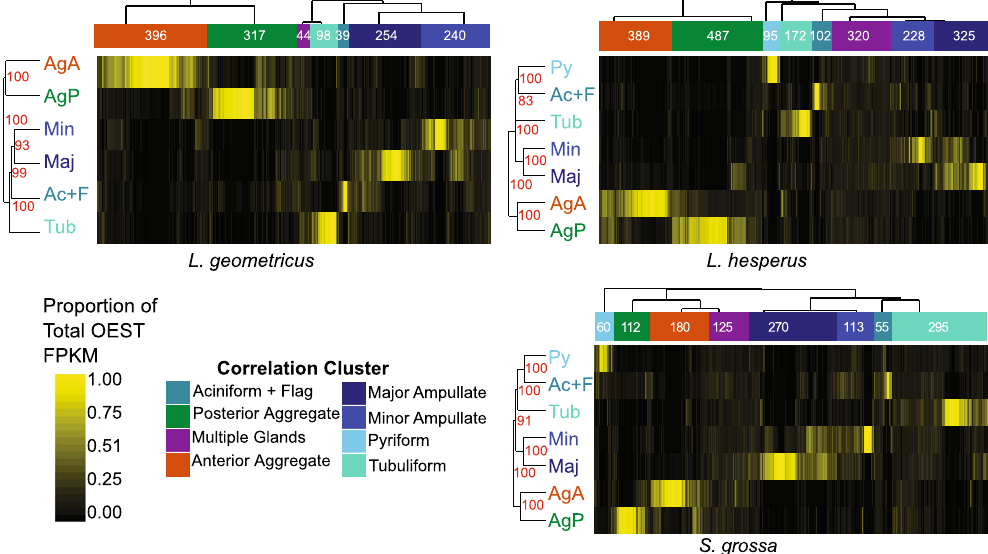
Figure 4. Expression patterns of over-expressed silk transcripts (OESTs). Within each focal species, transcripts significantly more abundant in silk glands than non-silk gland tissues (FDR < 0.05) were identified with edgeR. The common dispersions (CV 2 ) were 1.56 ( L . geometricus ), 1.55 ( L . hesperus ), 1.49 ( S . grossa ). OESTs were heirarchically clustered based on 1 – Spearman’s rho. Pairwise Spearman’s correlation coefficients between each OEST were calculated based on the proportion of the OEST’s mean FPKM in each of the seven silk gland types. Seven ( L . geometricus ) or eight ( L . hesperus , S . grossa ) clusters were identified and classified to an individual gland type or to mulitple glands according to majority of expression of all OESTs in the cluster (top dendrograms). The silk gland types were also heirarchically clustered according to 1 – Spearman’s rho, with correlation coefficients calculated from the proportion of OEST expression in each gland type (side dendrograms). Gland abbreviations and sample sizes as in Fig.